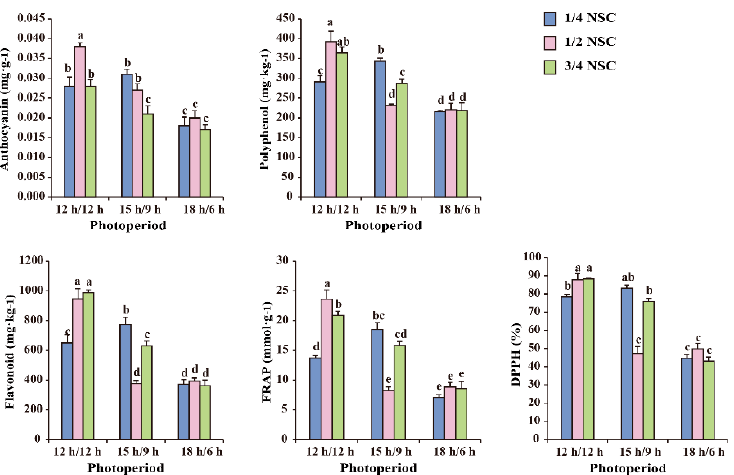
Figure 3. Anthocyanin, polyphenol, and flavonoid content and FRAP and DPPH in lettuce under the interaction of photoperiod and NSC. The letters marked in all figures mean the significance of differences ( p ≤ 0.05, Tukey’s test).